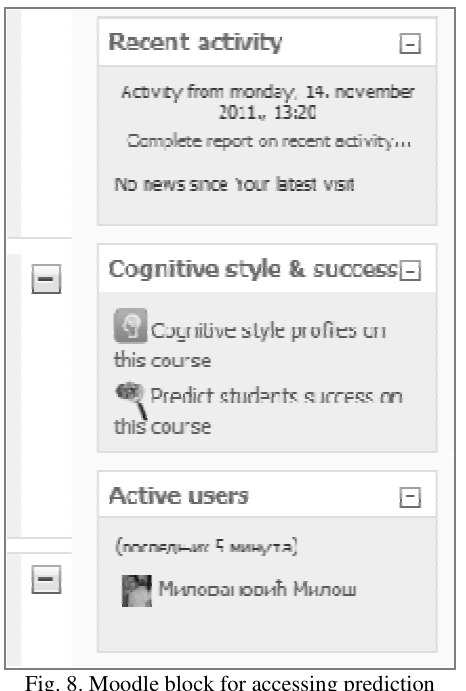
Fig. 8. Moodle block for accessing prediction